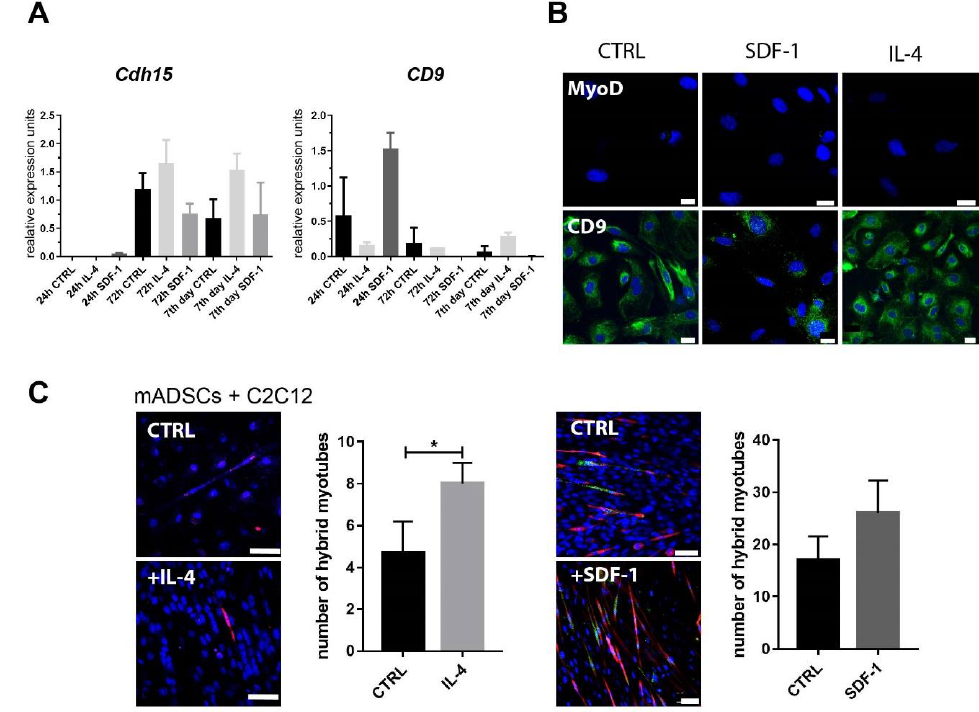
Figure 2. Characterization of mADSCs cultured under control conditions or in the presence of IL-4 or SDF-1. ( A ) Analysis of the level of mRNAs encoding M-cadherin (Cdh15) and CD9. Expression was related to the levels observed in control cells at day 0 (beginning of the culture) and normalized to mRNA encoding HPRT. ( B ) Localization of MyoD and CD9 (green) and nuclei (blue) in mADSCs after 7 days of culture, bar = 20 µ m. ( C ) Co-culture between mADSCs and mouse C2C12 myoblasts in the presence of IL-4 or SDF-1. Images on the left present localization of Orange CMRA (red) and nuclei (blue). Images on the right present localization of GFP (green), skMyHC (red), and nuclei (blue), bar = 50 µ m. Graphs present number of hybrid myotubes detected in five randomly chosen fields of view. For each experimental group n ≥ 3. Data are presented as mean ± SD. Data have been analyzed using Student’s t -test ( C ); Kruskal-Wallis test ( A ). * p <